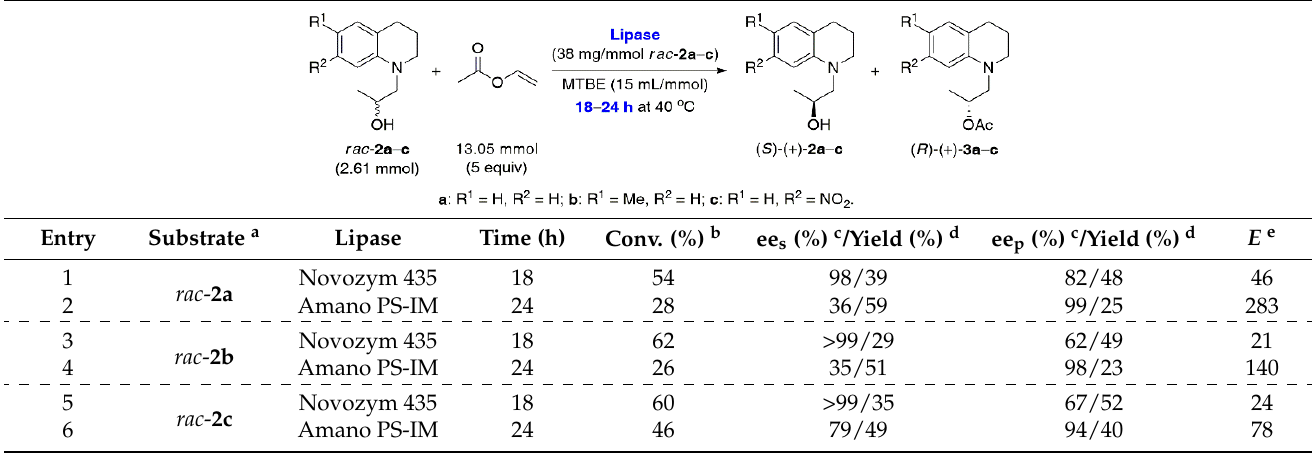
Table 5. Preparative-scale lipase-catalyzed KR of rac - 2a – c with vinyl acetate as acyl donor.